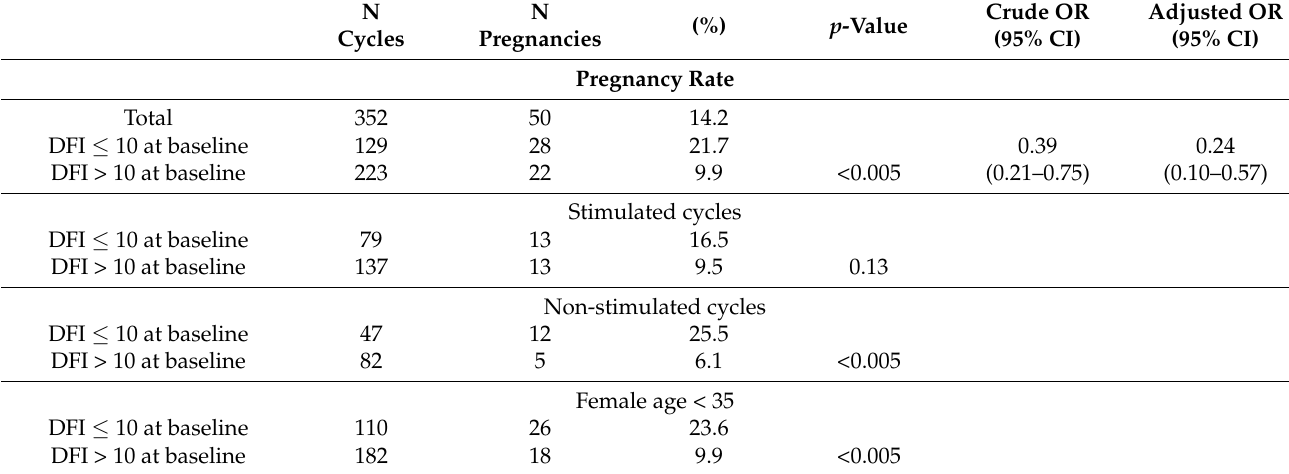
Table 4. Baseline DFI was analyzed before treatment was initiated. The spontaneous pregnancies obtained between enrolment but before treatment was initiated was included in the total population but excluded in the groups with the stimulated vs. non-stimulated